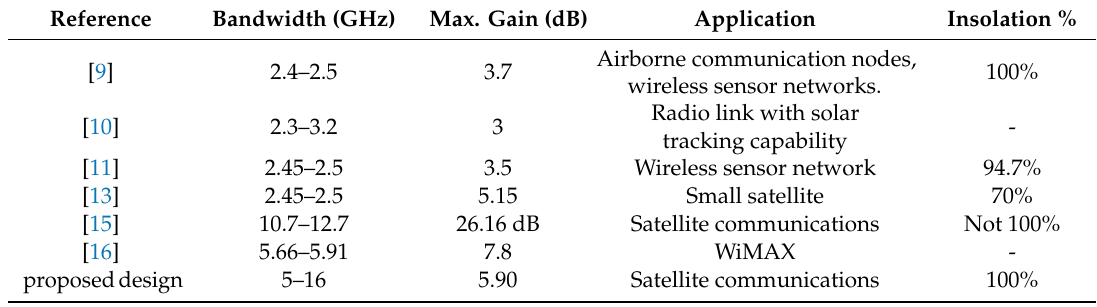
Table 3. Comparison of the proposed antenna with those reported in the